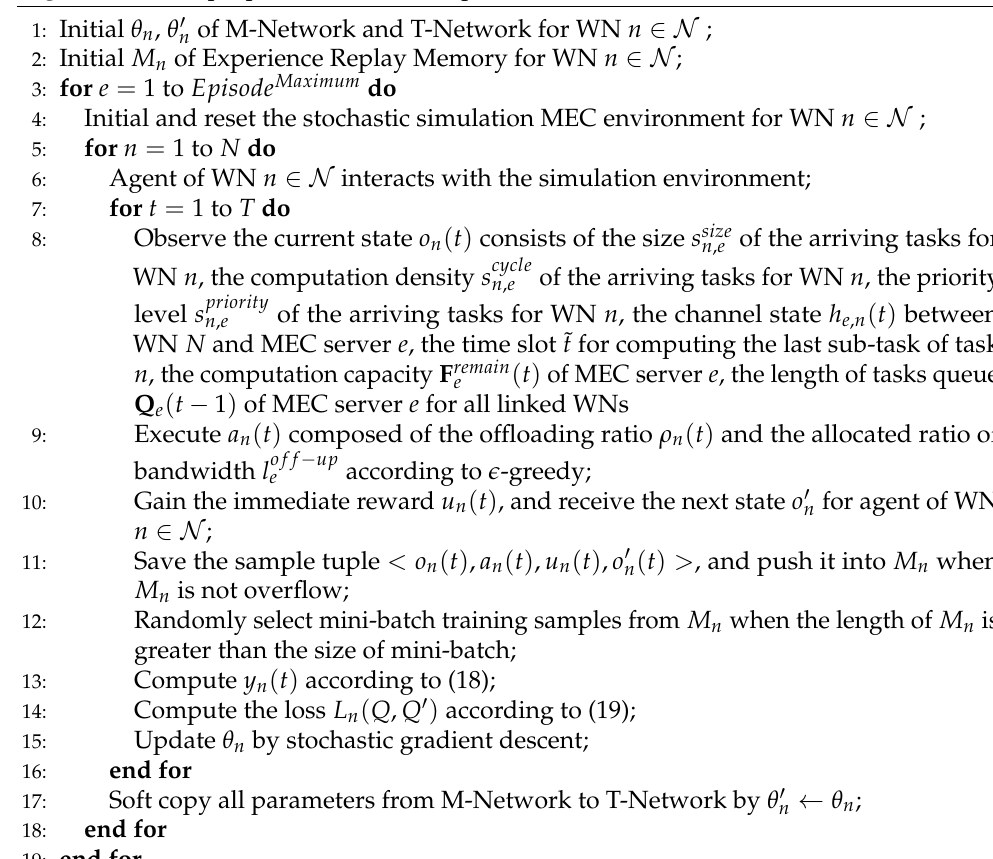
Algorithm 1 The proposed DRL-based optimization